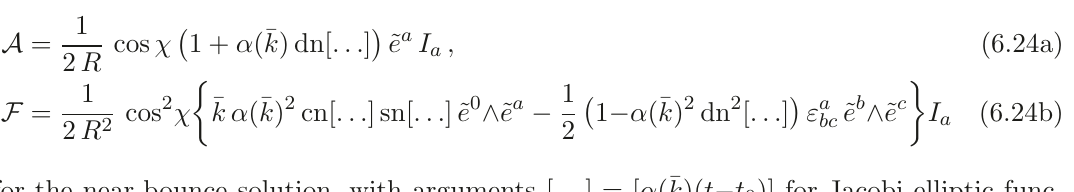
Figure 4 . Bounce (yellow) and 2 π -periodic (blue) solution in the double-well potential (3.15). for the colour-magnetic